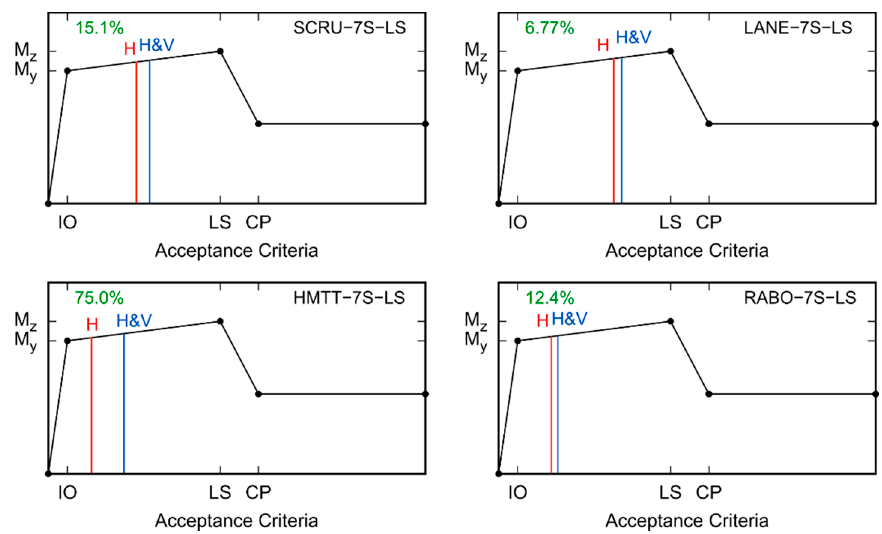
Figure 24. Examples of acceptance criteria for the 8-story building. Part 1.